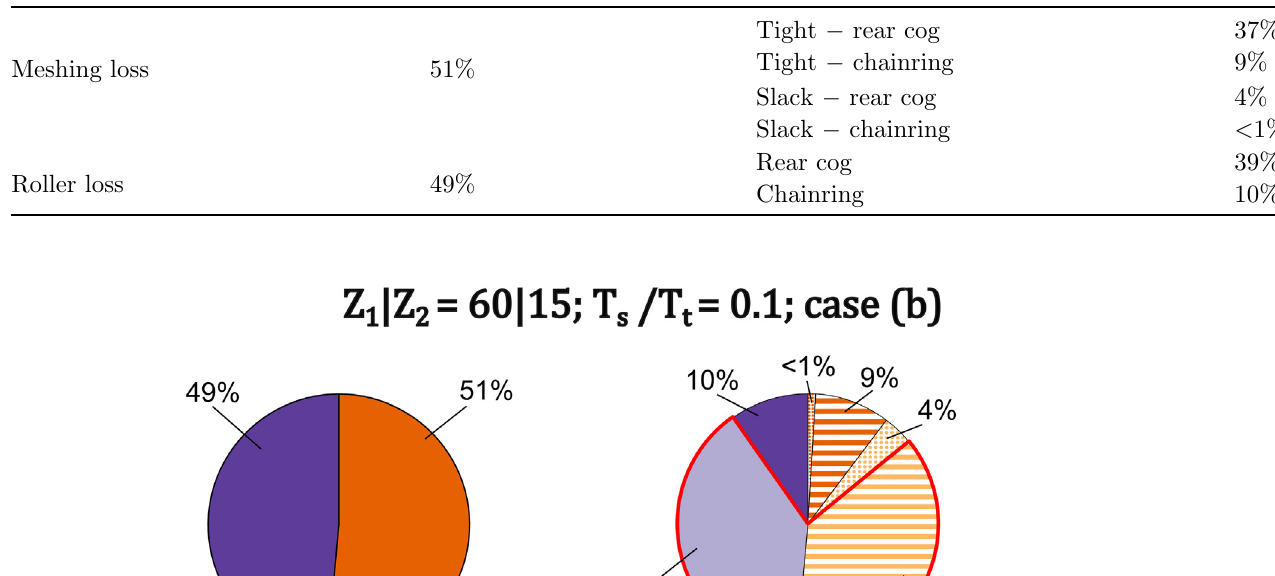
Table 4. Detailed proportion for 60|15; T s / T t = 0.1 ; case (b).